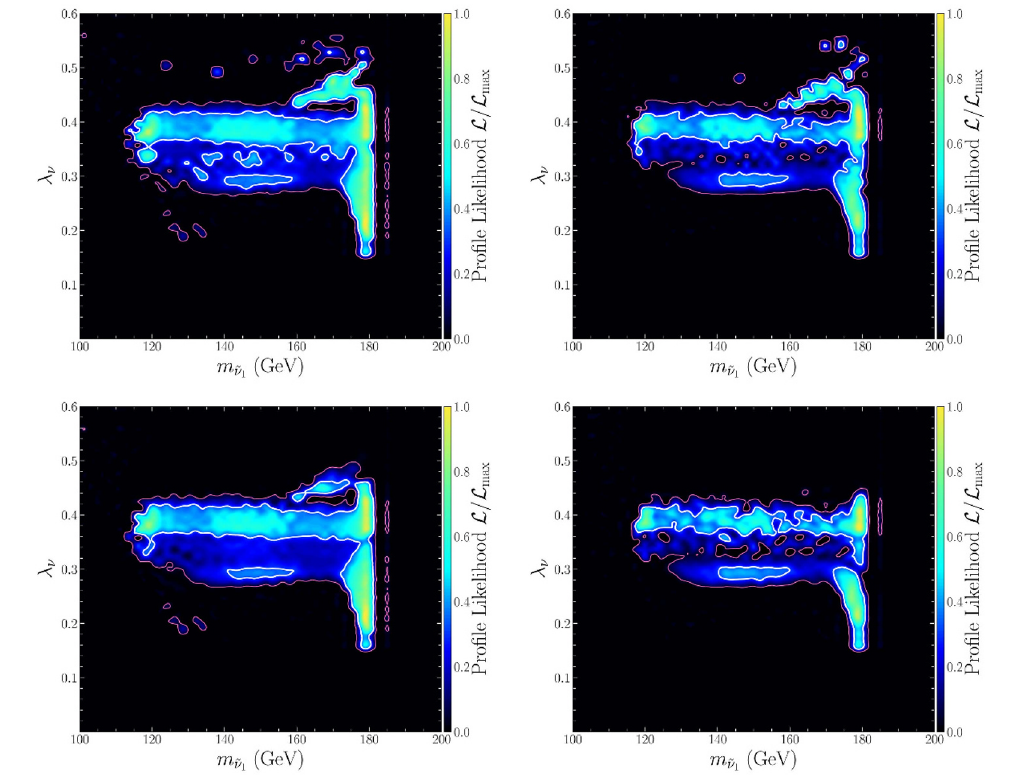
Figure 1 . The profile likelihoods of the function L DM in eq. (3.1) for the light h s scenario, projected onto λ plane. The upper panels are the results for the B = 0 case, where the bounds of ν − m ˜ ν 1 µ X 6 the DM-nucleon scattering cross-section were taken from the XENON-1T (2018) experiment (left panel) and the future LZ experiment (right panel), respectively. The lower panels are same as the upper panels except that they are for the B = 0 case. Since χ 2 ’ 0 for the best point of the µ X min scans, the boundaries of the 1 σ and 2 σ confidence interval satisfy χ 2 ’ 2 . 3 and χ 2 ’ 6 . 18 and are marked with white and red solid line, respectively. This figure reflects the preference of the DM measurements on the parameters λ and m ν ˜ ν 1